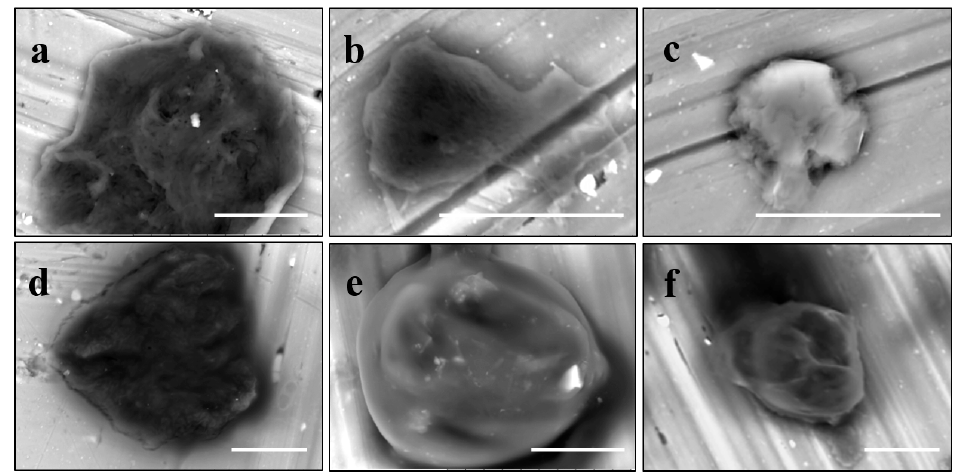
Figure 6. SEM micrographs of the wet lipobeads prepared by polymerization inside GMVs ( a – c ) or giant unilamellar vesicles (GUVs) ( d – f ) and deposited on the aluminum SEM mounting stub (scale bars = 10 µm).